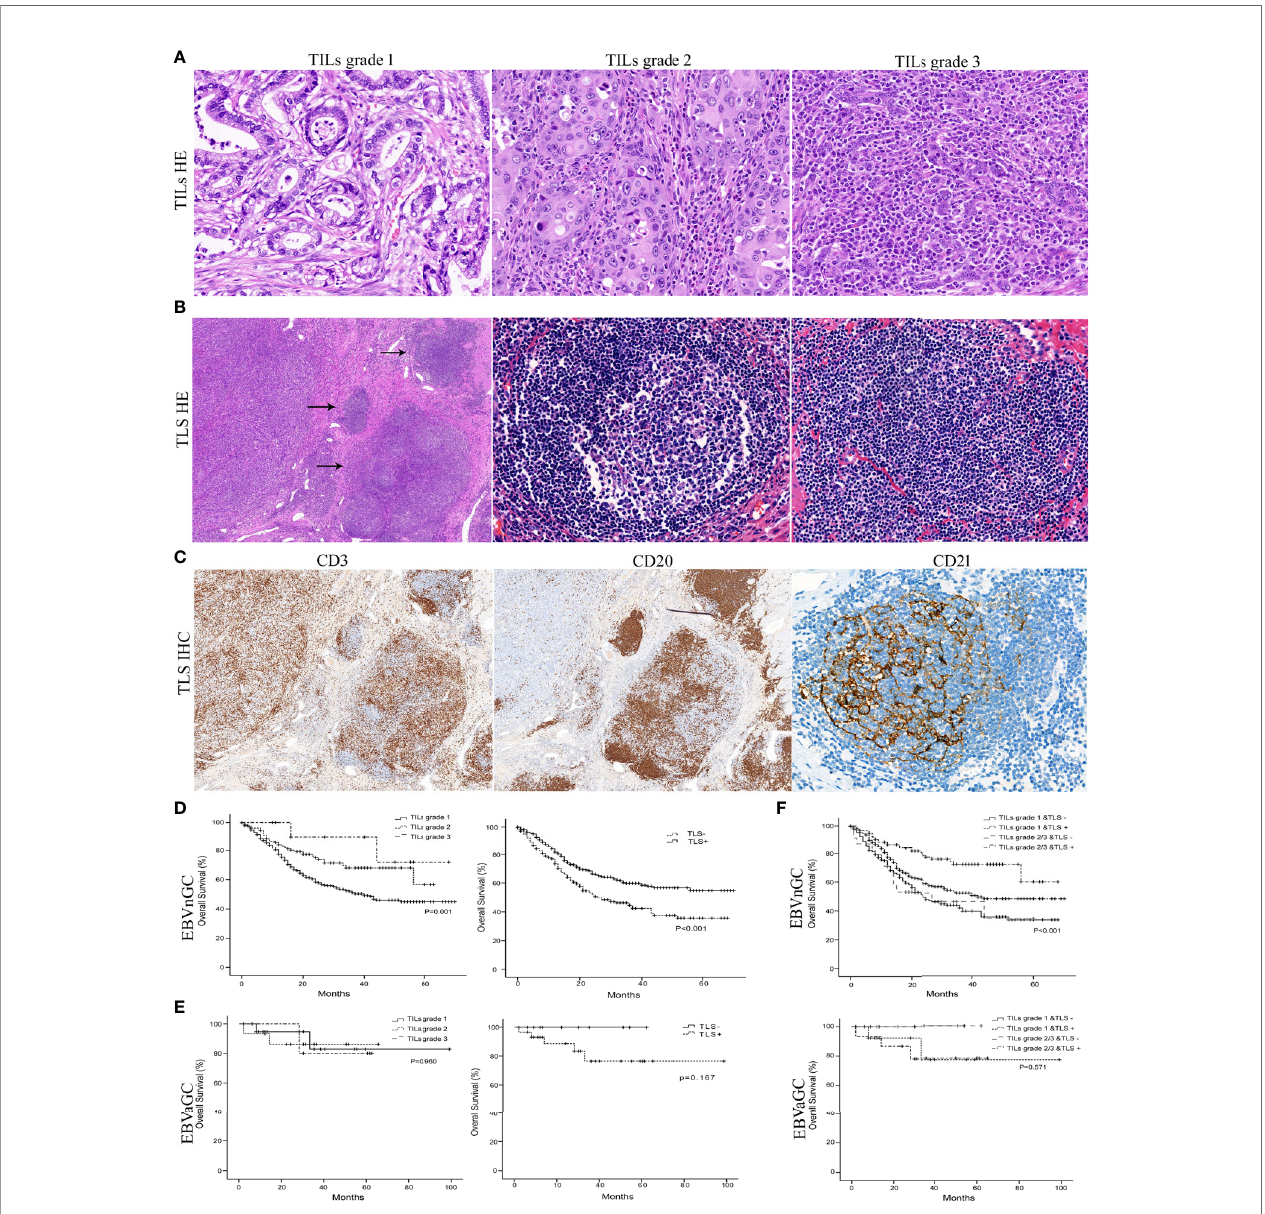
FIGURE 2 | Histology of the TILs grade, TLS, and survival curves in EBVaGC and EBVnGC. (A) The mean percentage of the stromal area occupied by lymphocytes and plasma cells within tumor was assessed as TILs grade 1 (minimal, ≤ 10%), grade 2 (moderate, 10 – 50%), and grade 3 (abundant, >50%) (H&E, ×400). (B) TLS (arrows) with or without germinal centers (center) were mainly localized at the invasive margin of cancer (left fi eld) (H&E, left ×50, center ×400, right ×400). (C) Whether germinal centers were visible or not, clusters of CD20 + B lymphocytes (×50) in TLS were surrounded by CD3 + T cell areas (×50) and contained a network of CD21 + FDCs (×400) by immunohistochemical staining. Kaplan-Meier survival analyses for overall survival were performed according to the TILs grade, TLS, or TILs & TLS in EBVnGC (D, F) top and EBVaGC (E, F)